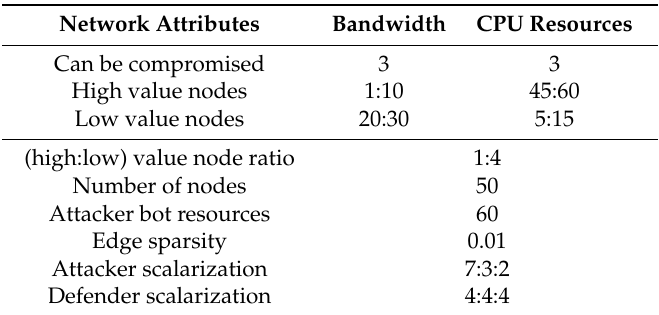
Table 7. Configuration for a complex